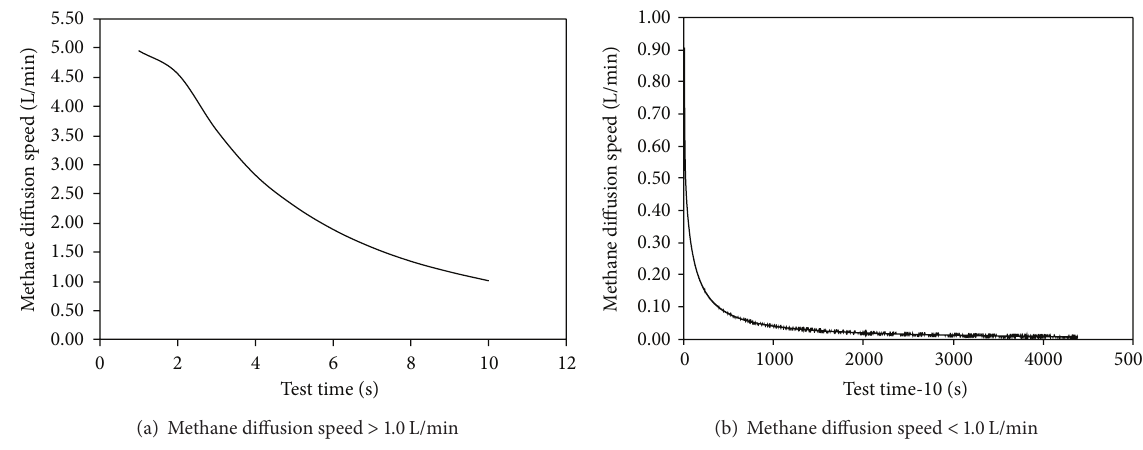
Figure 3: Characteristic curve of methane diffusion speed (methane pressure is